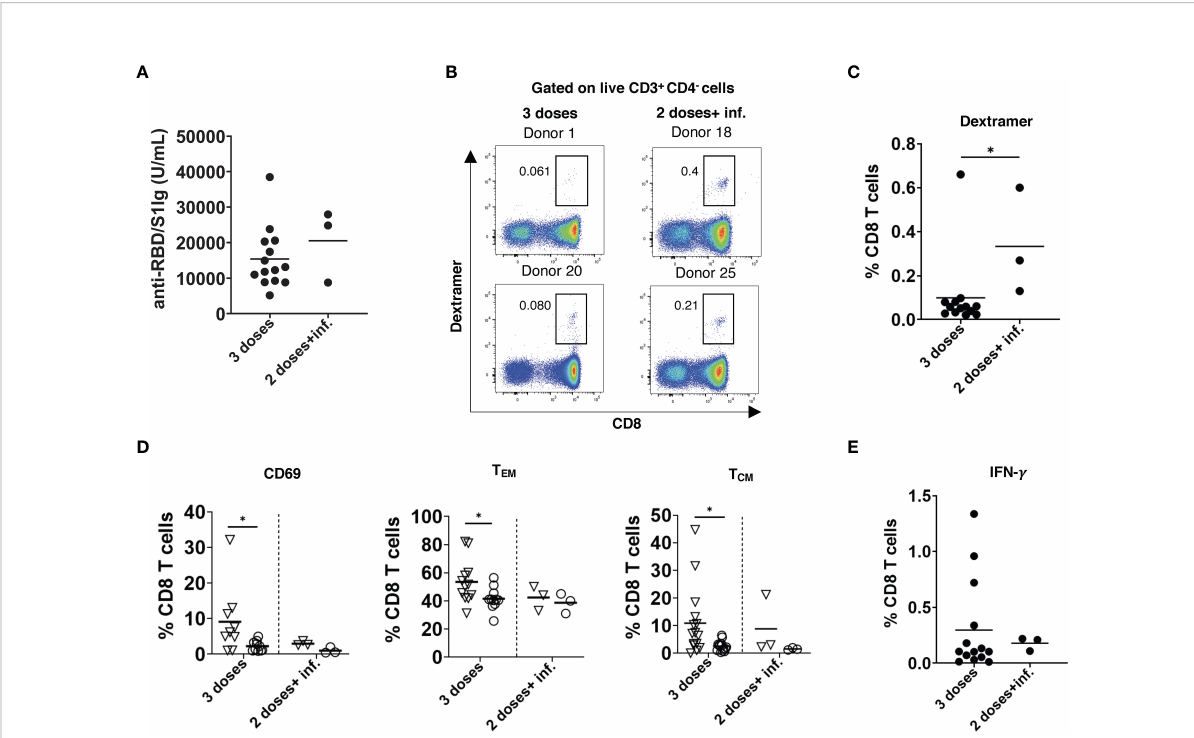
FIGURE 5 Effect of breakthrough SARS-CoV-2 infection on antibody and T cell responses in vaccinated participants. (A) Total RBD/S1 Ig were measured in the serum of participants infected after 2 doses of vaccination (2 doses + inf.; n=3) or after 3 rd dose (n=14) and expressed as U/mL. (B) Representative dot plots for SARS-CoV-2 spike speci fi c CD8 T cells (dextramer + CD8 + ) from both groups. (C) Spike-speci fi c CD8 + T cells infected after 2 doses of vaccination (n=3) or after 3 rd dose (n=14) are shown as the percentage of dextramer + CD8 + T cells within total CD8 T cells. (D) Frequency of spike-speci fi c CD69 + , T EM , and T CM CD8 T cells after infection (n=3) and 3 rd dose of vaccination (n=14) are presented as the percentage within total CD8 T cells. Dextramer + CD8 + and dextramer - CD8 + are indicated as inverted triangles and circles, respectively. (E) PBMC were stimulated with SARS-CoV-2 S peptide pool and anti-CD28 mAb for 6h. Data are presented as the percentage of IFN- g + CD8 + T cells among total CD8 T cells (n=3 and 14 respectively). * P <